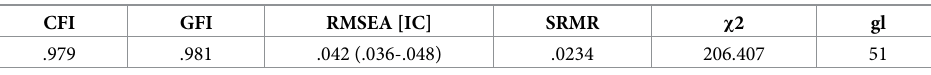
Table 4. Goodness-of-fit indicators of the CFA model, three factors (random sample b; n = 1735).